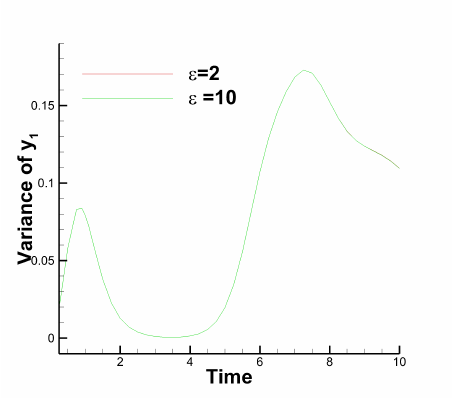
Figure 7. The time evolution of the variance of y 1